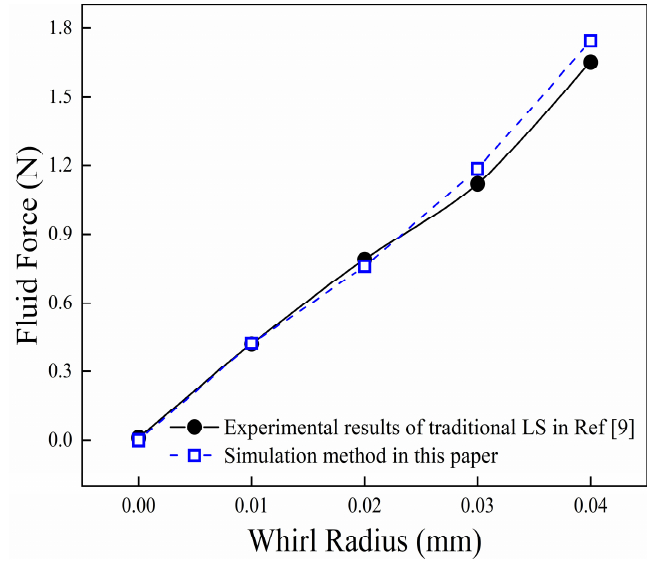
Figure 6. Simulation reliability validation.